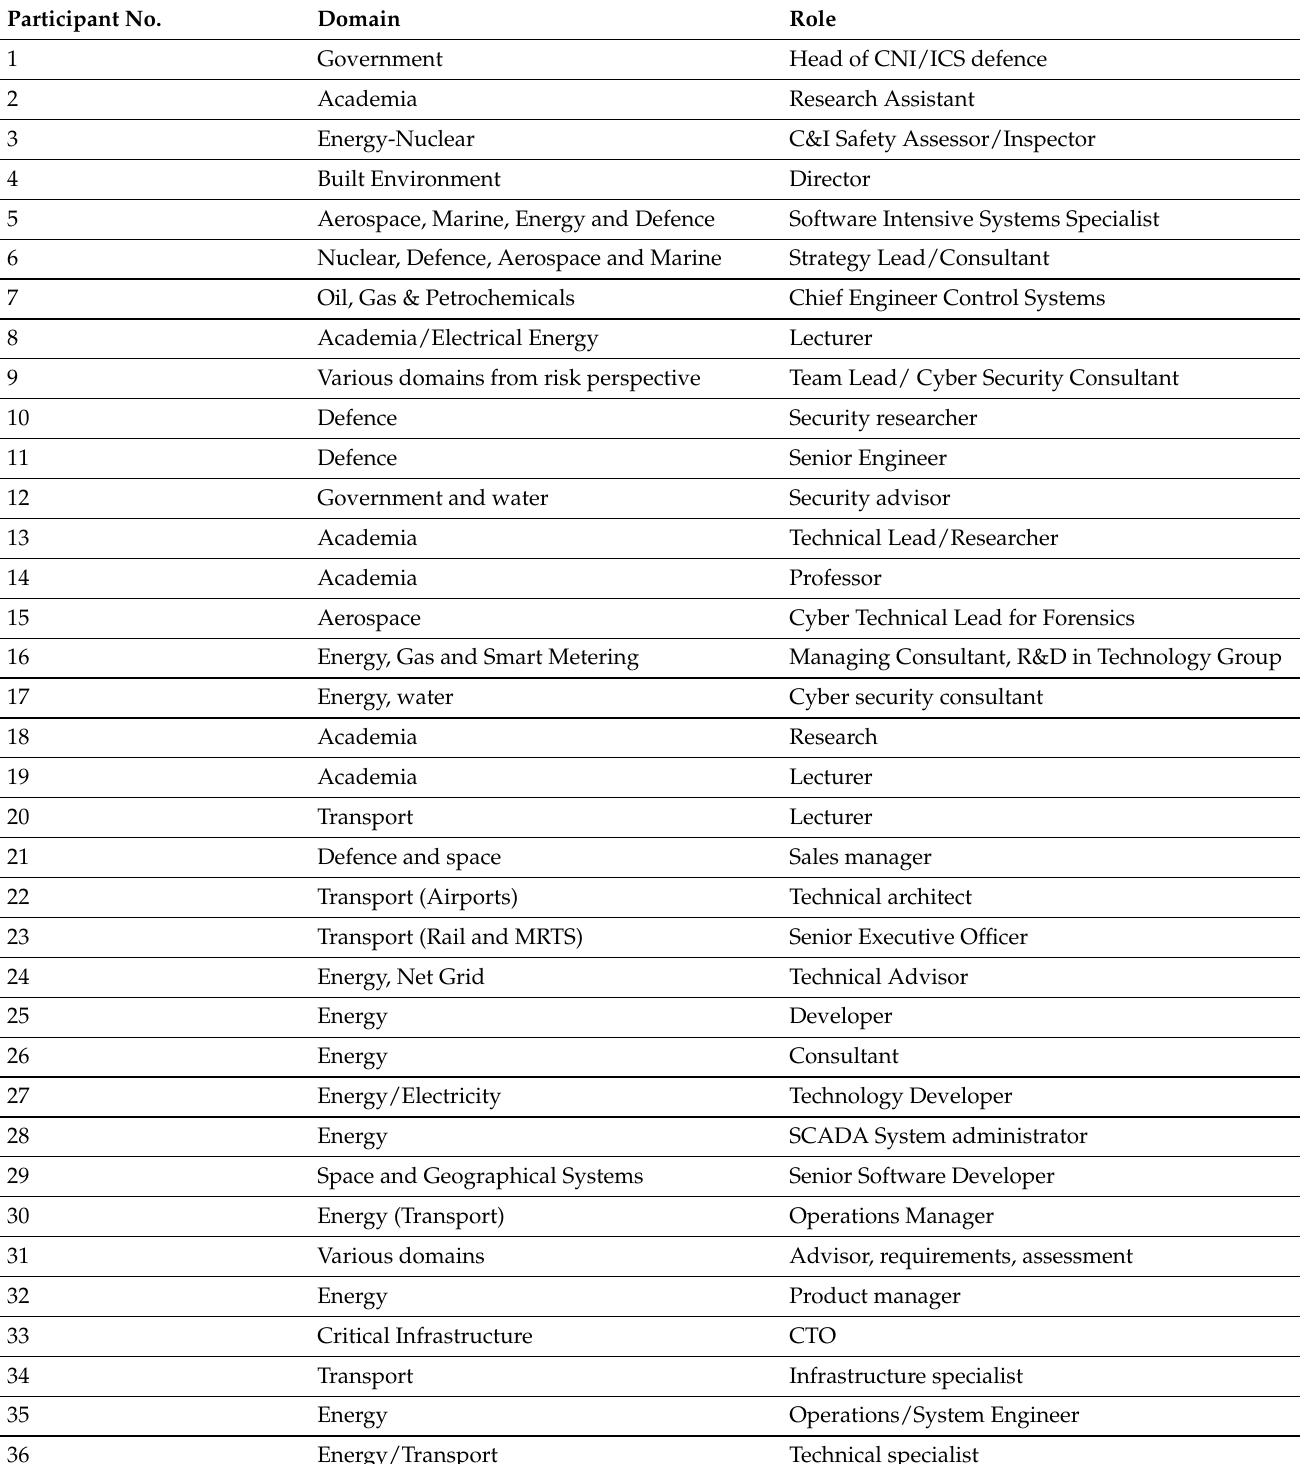
Table A1. Participants’ Profile. Domains and